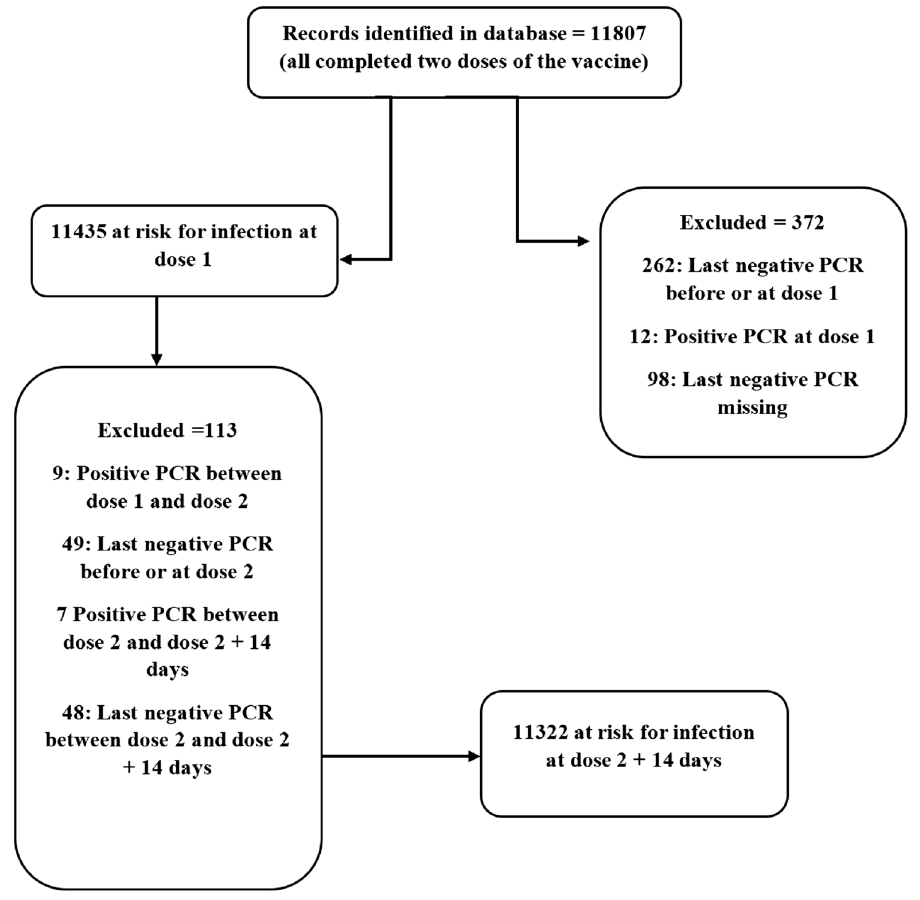
Figure 1. Flow chart explaining inclusion and exclusion for